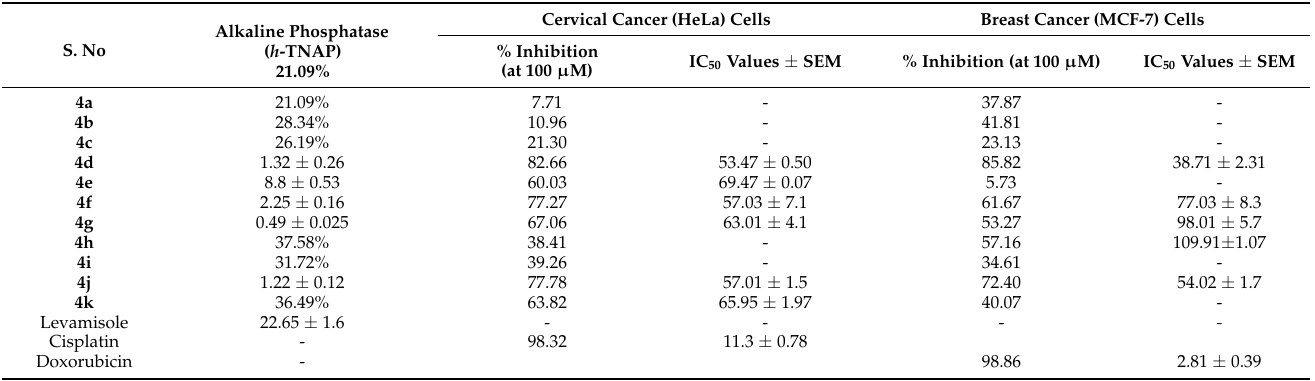
Table 2. IC 50 values and percent inhibition of compounds 4a – 4k tested against h -TNAP, HeLa, and MCF-7 using levamisole, cisplatin, and doxorubicin as standard